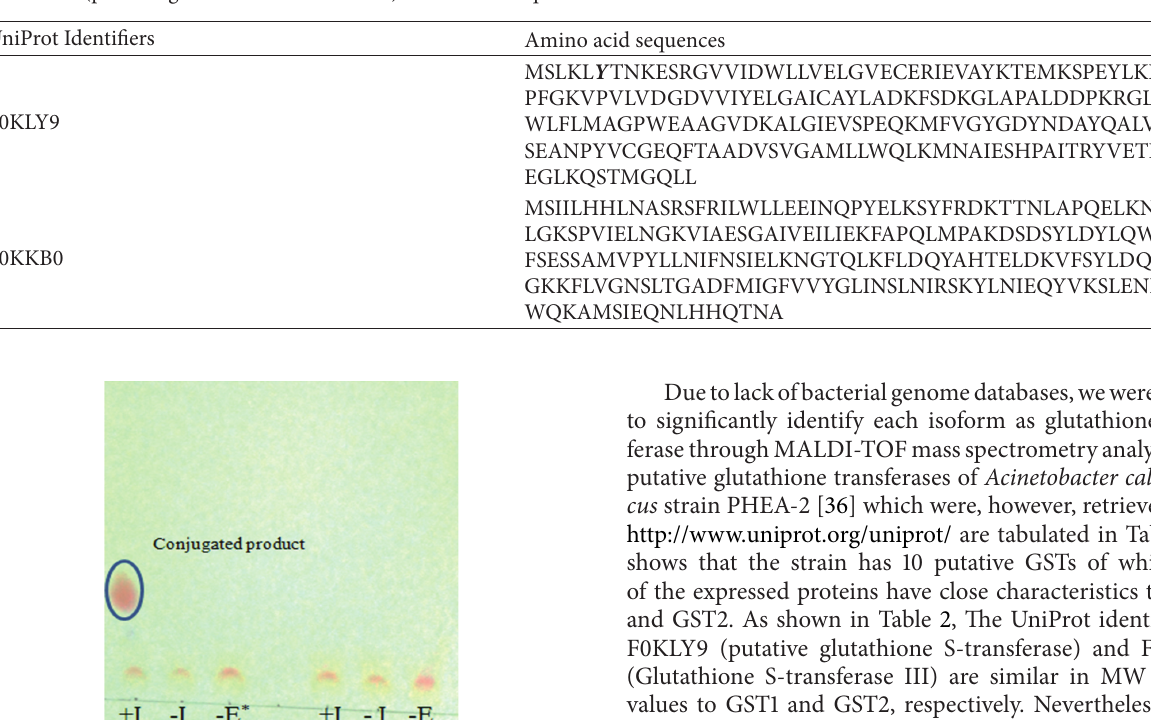
Table 3: Protein (FASTA) sequences for F0KLY9 (putative glutathione S-transferase) and F0KKB0 (glutathione S-transferase III) were retrieved from http://www.uniprot.org/uniprot/ . Bold and italic is the identified active residue (Y, S, or C at positions 5 or 6) which is present in F0KLY9 (putative glutathione S-transferase) amino acid sequence.